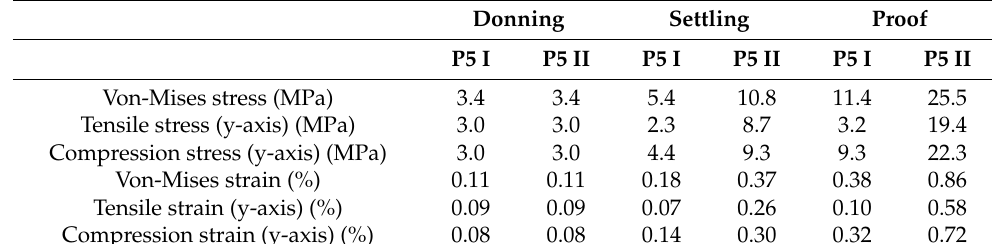
Table 4. Summary of maximum stress and stain numerical results for all loading conditions.